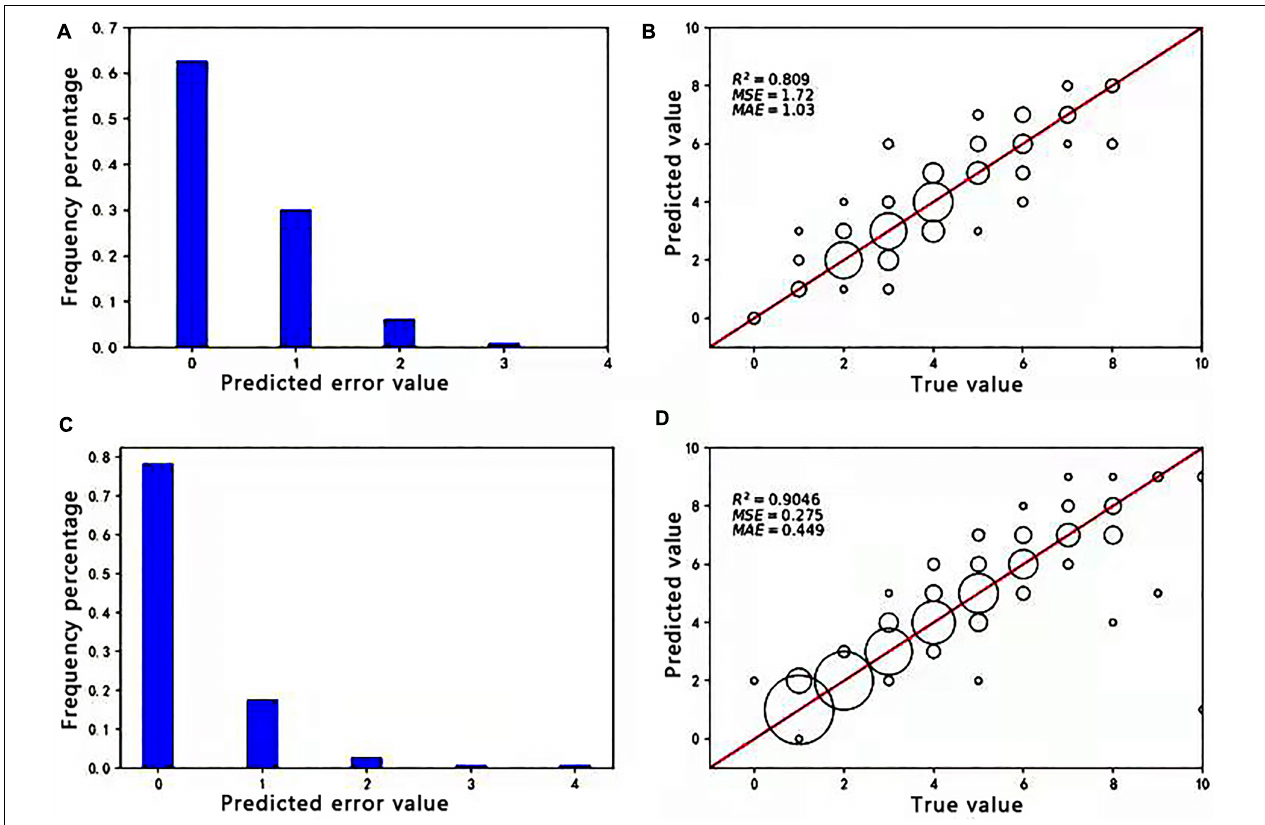
FIGURE 4 | Absolute values of the difference between true and predicted values of soybean flowers and pods and correlation analysis between manual and soybean flower and pod counting. (A) Absolute values of the difference between true and predicted values of soybean flowers. (B) Correlation analysis between manual and the Faster R-CNN (ResNet50) model for soybean flower counting. (C) Absolute values of the difference between true and predicted values of soybean pods. (D) Correlation analysis of soybean pod counting by manual and the Faster R-CNN (CSPResNet-50)